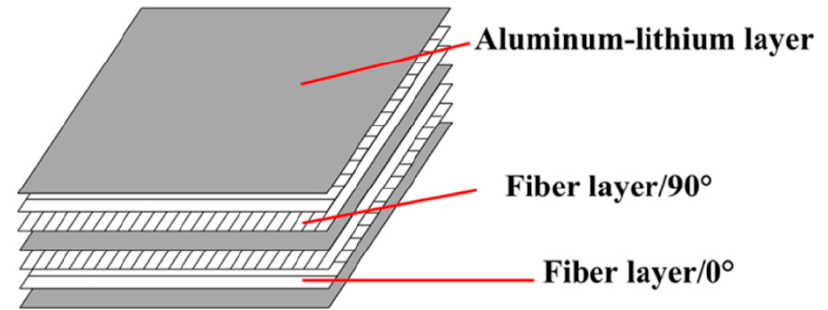
Figure 11. The laminating design of novel fibre–metal laminates (reprinted with permission from [136]; copyright© 2021, Springer-Verlag London Ltd., part of Springer Nature). The curvature radius of NFML strips decreases when the upper metal layers are etched, indicating that the processed upper layer experiences a compressive state of stress [45]. It was found that the decreased curvature radius is only achieved for NFMLs after etching the lower metal layer (Figure 12). This proves that a state of tensile stress exists in the lower layer. The residual stresses vary at the fibre–metal and 0 ◦ –fibre–90 ◦ interface due to the different material modulus of each component (Figure 13). The change in stresses at the interphase boundaries results from a rapid change in the deformation behaviour of the layers. Undoubtedly, due to the layered structure of FMLs, the residual stresses are distributed in a more complex manner than in homogeneous